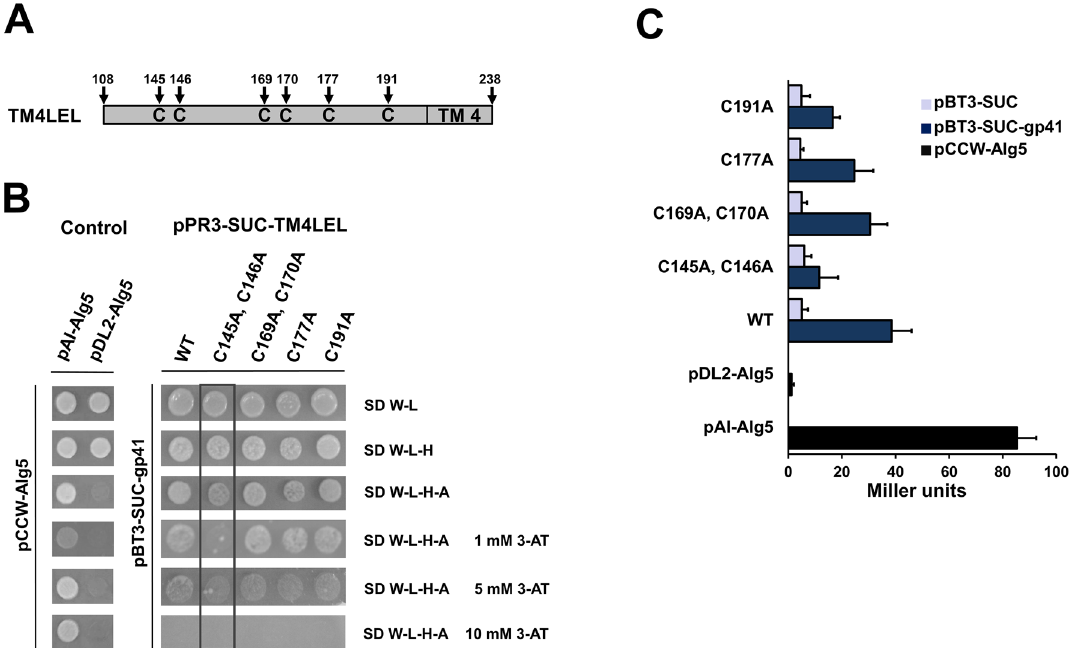
Figure 2. Impact of cysteine mutations in the LEL sequence of CD63 on the interaction with gp41. ( A ) Schematic representation of the cysteine positions within the expression prey construct pPR3-SUC-TM4LEL (not to scale). TM4LEL, the transmembrane domain 4 and LEL of CD63 ( B ) NMY51 interaction yeast growth assay . Yeast cultures co-transformed with the pBT34-SUC-gp41 bait and prey vector pPR3-SUC-TM4LEL marked with a frame. ( C ) β-galactosidase activity was assayed for each co-transformed yeast culture in order to address the interaction strength. Each value is given in Miller units and 5 represents the result of β-galactosidase activity assay using three independent yeast